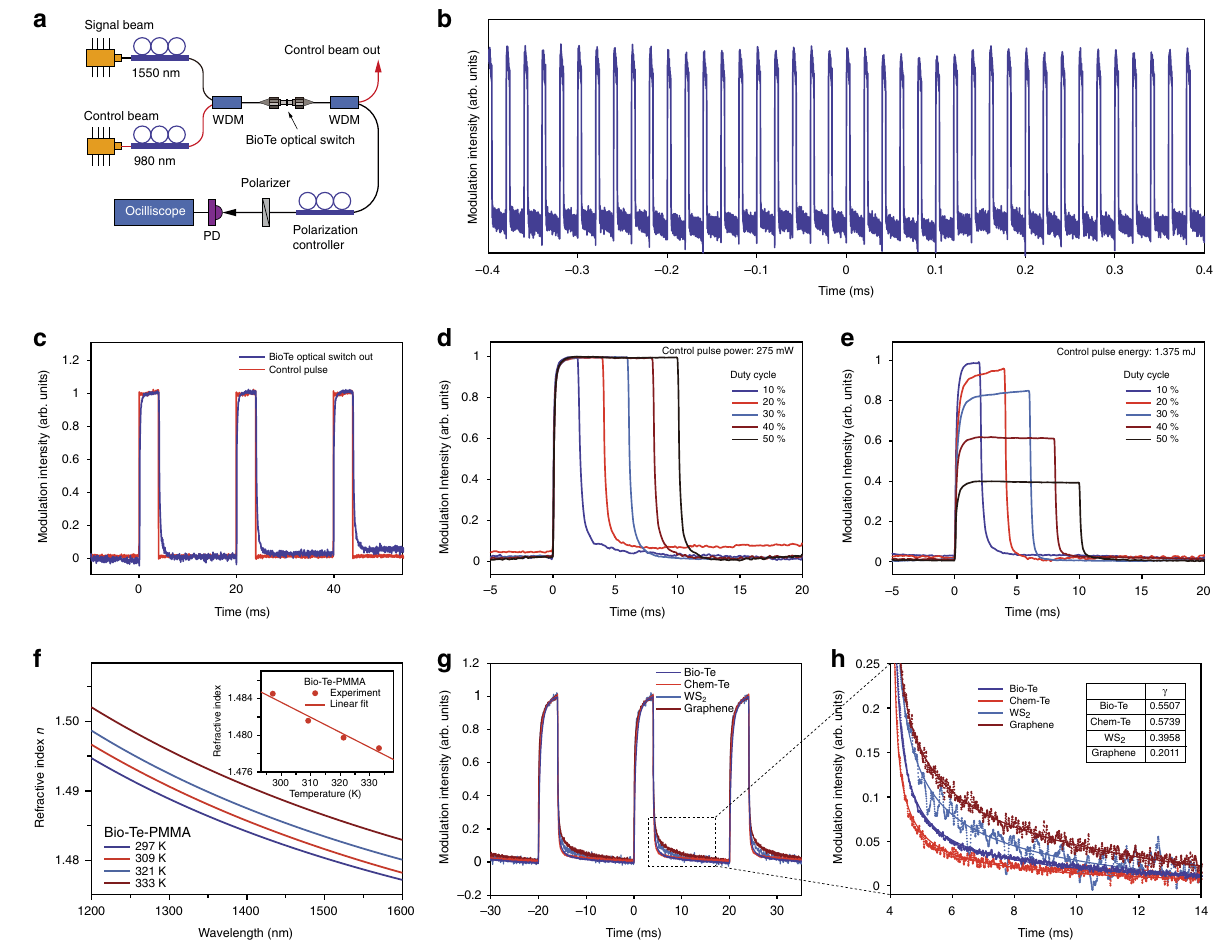
Fig. 5 Demonstration of all-optical switch based on biologically synthesized tellurium. a Scheme for testing the performance of a Bio-Te optical-switch based on polarization interference. b Long-term output waveform of the Bio-Te optical-switch, indicating its output stability. The average power and duty cycle of the controlling 980 nm pulses were 55 mW and 20%, respectively. c Comparison of the signal input to the output from the Bio-Te optical switch. The rise time and fall time were measured as 276.3 μ s and 563.0 μ s. d , e Effect of duty cycles of the control pulse on the output of the Bio-Te optical switch when the control pulse ’ s peak intensity (d) or pulse energy (e) remains constant. f Refractive index of Bio-Te-PMMA fi lm measured at different temperatures by an ellipsometer. Inset: the refractive index at 1.55 μ m as a function of temperature. g Comparison of the output waveforms based on various fi lms serving as working material for optical switching, showing the recovery lifetimes of different materials. h Enlarged image from the marked area in (g) showing the performance in signal decay of different materials once the control pulse was turned off. The falling times are determined to be 764 μ s and 476 μ s for Bio-Te and Chem-Te, and are 1.440 ms and 2.200 ms for WS 2 nano fl akes and graphene, respectively. Solid lines are fi tted to the power law, y / t (cid:2) γ . Inset table: the exponent, γ , from the fi t of the power